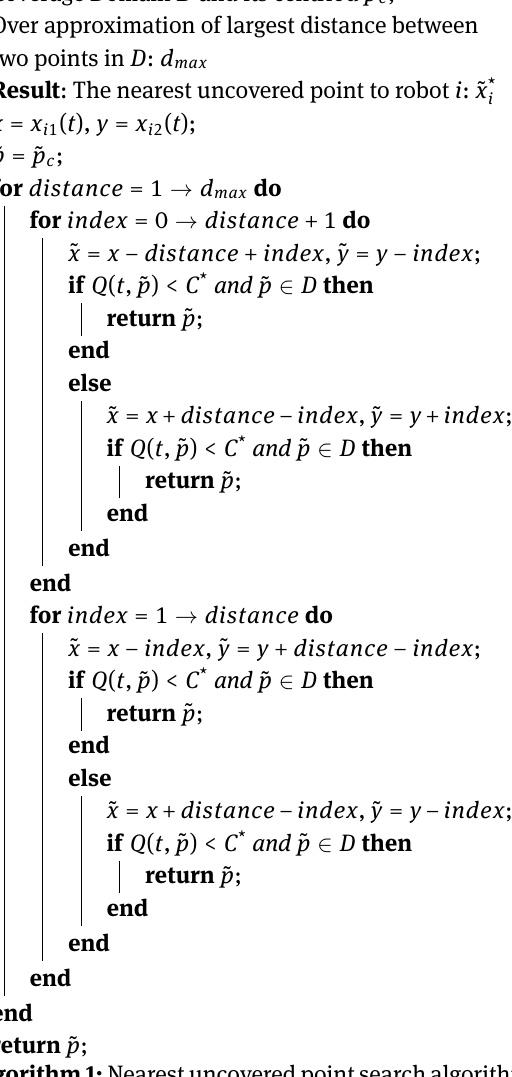
Algorithm 1: Nearest uncovered point search